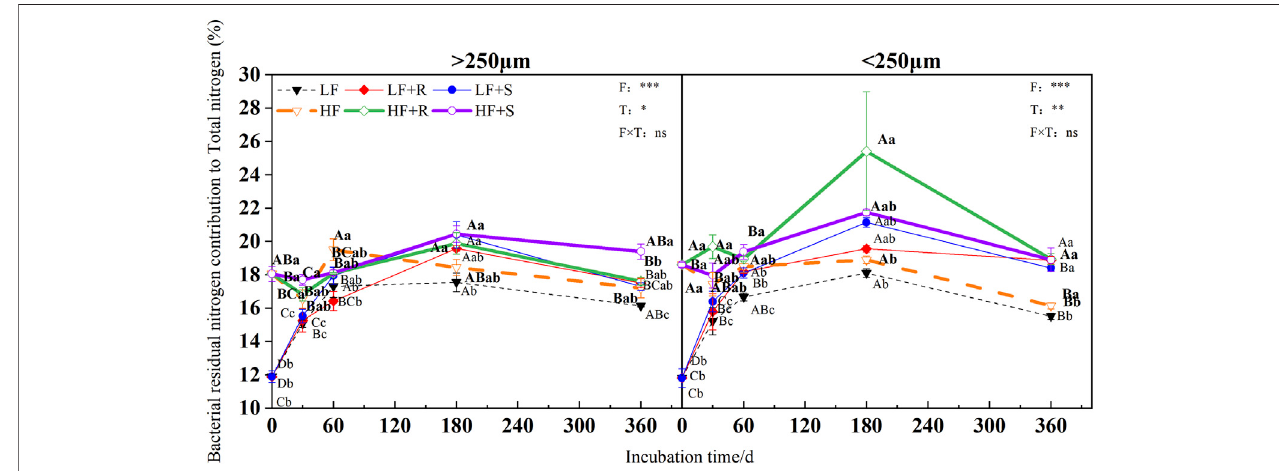
FIGURE 7 | Bacterial residual nitrogen contribution to total nitrogen in soil aggregates with different fertility levels after the addition of different parts of maize residues.Note:LFmeanslowfertility,LF+Rmeanslowfertility+roots,andLF+Smeanslowfertility+Shoots;HFmeanshighfertility,HF+Rmeanshighfertility+roots, and HF + S means high fertility + Shoots. Uppercase letters represent differences between different periods in the same treatment, and lowercase letters represent differences between different treatments at the same period. For the ANOVA, F means fertility level, T means the type of maize residues, and F × T means fertility level × type of maize residues. *,**, and *** mean p < 0.05, 0.01, and 0.001, respectively. ns means no signi fi